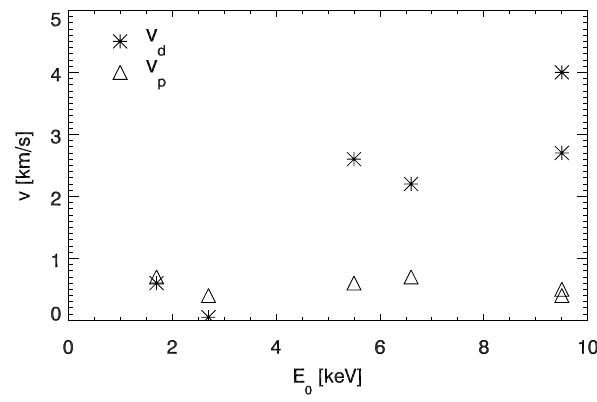
Fig. 11. Scatter plot of the observed black auroral drift ( v d , aster- isks) and measured plasma flow velocity ( v p , triangles) against the characteristic energy ( E 0